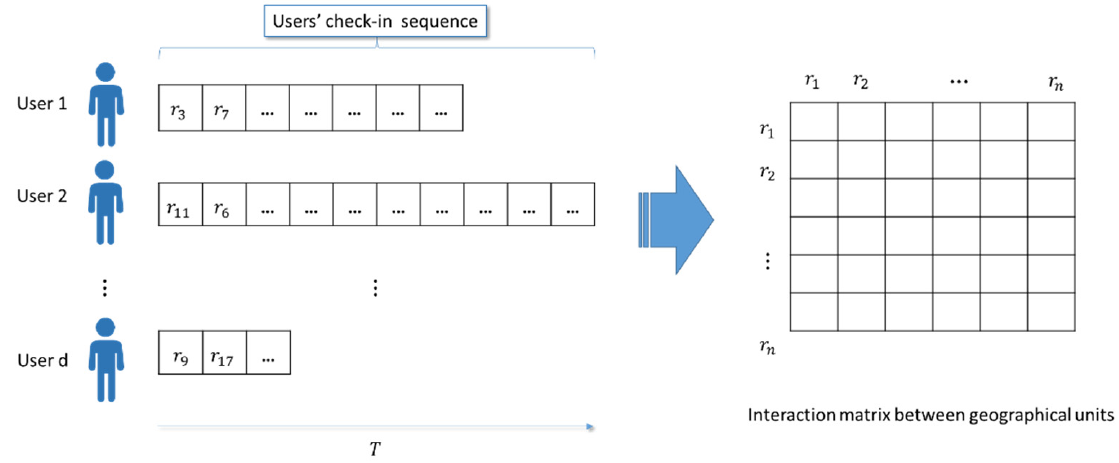
Figure 9. Three geographical unit partitioning schemes, depending on the minimum specified number of check-ins: ( a ) 116, ( b ) 228, and ( c ) 341 cells were obtained when the minimum number of check-ins was set to 300, 150, and 100, respectively.